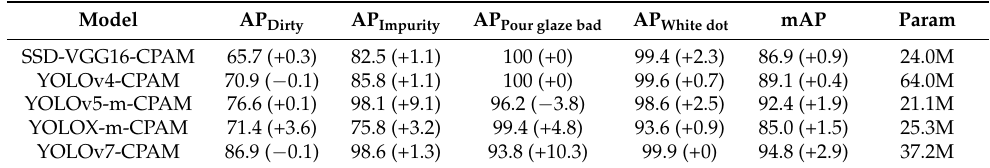
Table 9. The results of different models with